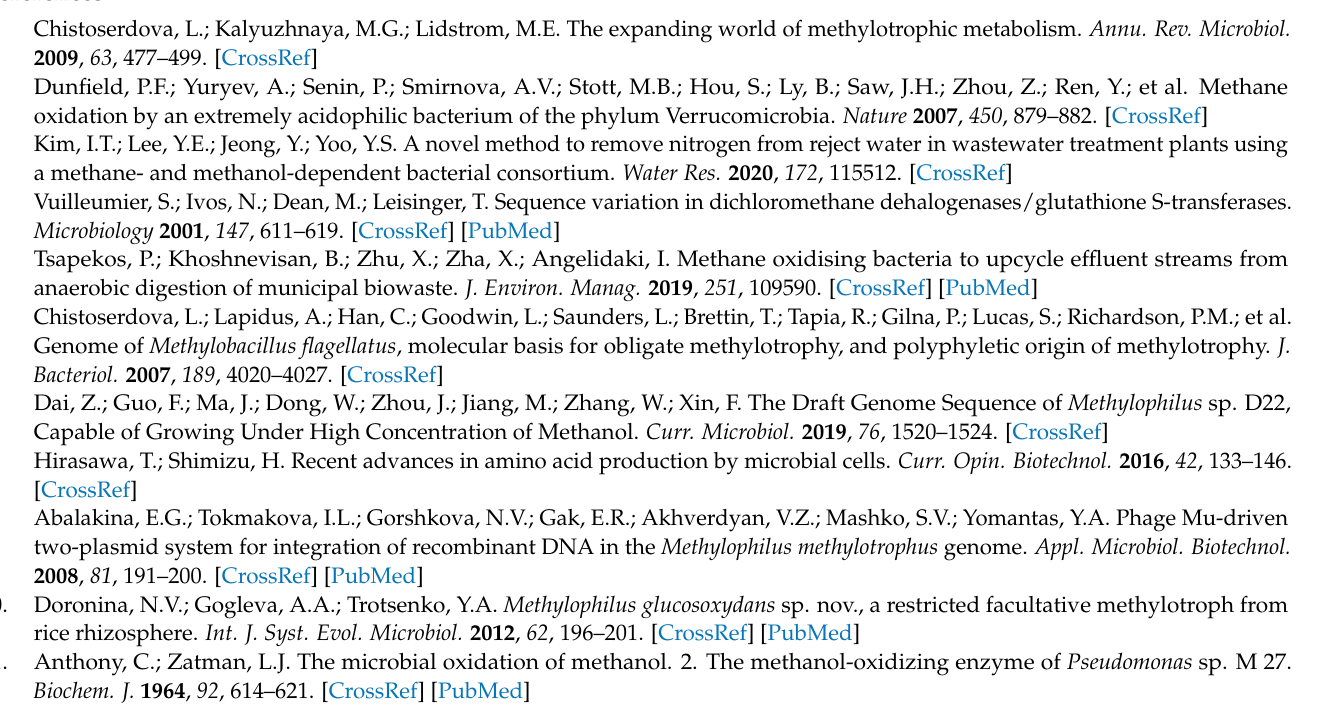
according to CAZy results, Table S1: 16S rRNA gene sequence similarity and ANI values, Table S2: Specific genes of 18 genomes among various environments, Table S3: Statistical analysis data in methanol metabolism, nitrogen metabolism, sulfur metabolism and cellular electron transfer